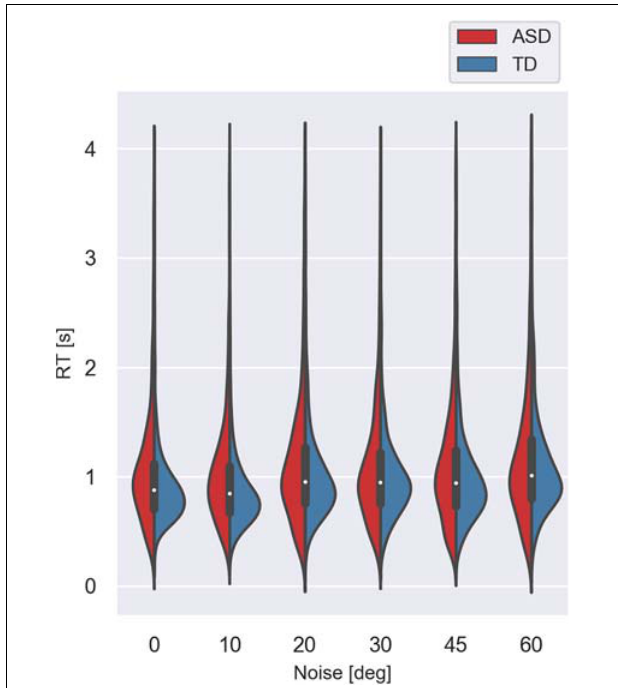
FIGURE 6 | Violin plot of the variance of response times for the two groups with different development at different noise levels. The values lower than 0.25 s and higher than 4.0 s were